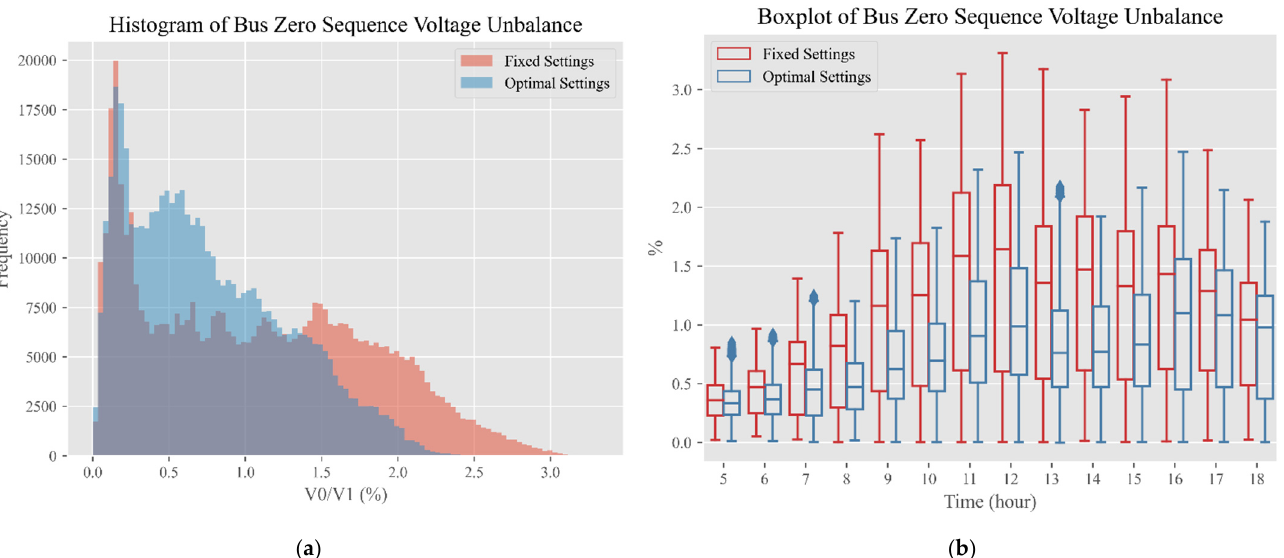
( b ) Boxplot in each hour Figure 12. Negative sequence voltage unbalance: ( a ) Histogram; ( b ) Boxplot. The maximum zero-sequence voltage unbalance is decreased from 3.32% to 2.47%, and the average zero-sequence voltage unbalance is decreased from 1.08% to 0.76%. The maximum negative-sequence voltage unbalance is decreased from 3.16% to 2.52%, and the average negative-sequence voltage unbalance is decreased from 0.82% to 0.54%. The sequence voltage unbalances are significantly mitigated, and most of them are reduced to under 1.5%. The improvement near noon is also better than those in the morning and at nightfall due to the high output of the PV at noon in most patterns, as shown in Figure 6. 5.3. Tap Changing The number of changes in VR tap positions and SCB status are optimized together for equipment deferred substitution, as expressed in Equation (7). Table 3 lists the equip- ment operation times, and Figures 13–16 show the three-phase tap positions of four VRs during the simulation period. The total number of changes in the VR tap positions are